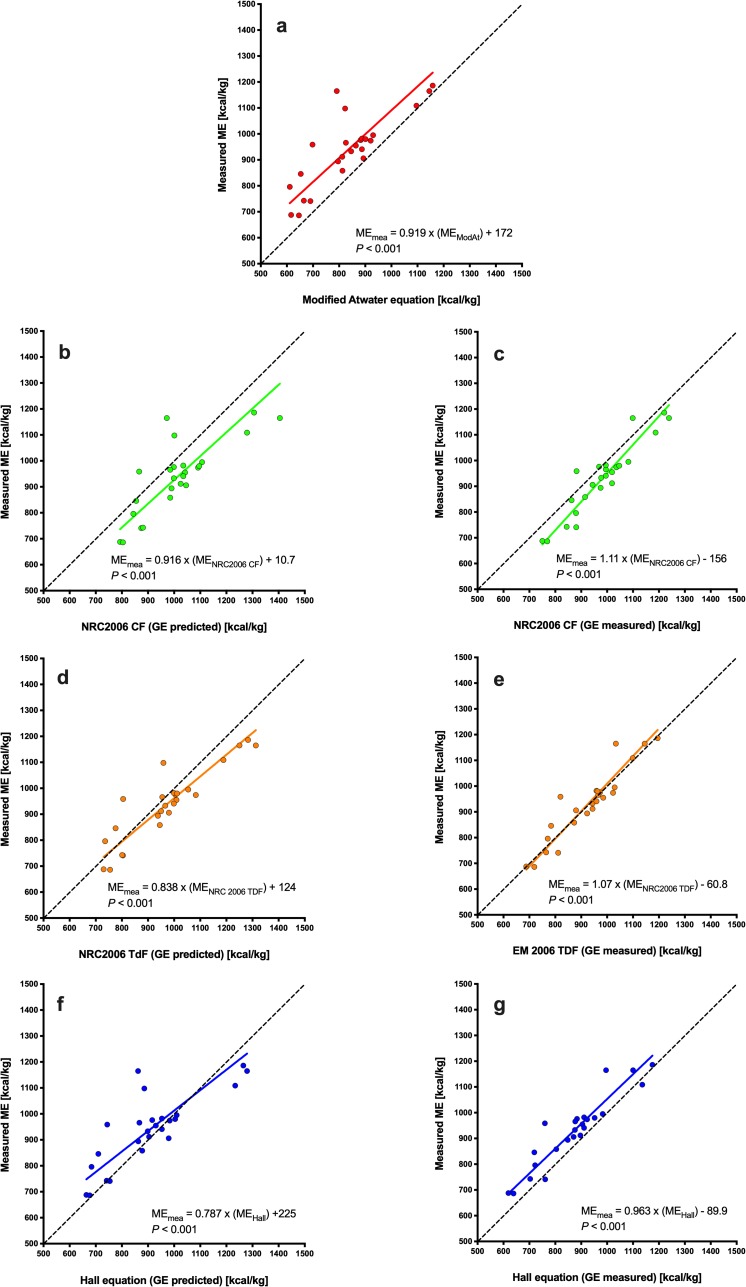
Deming regression plot depicting the relationship between measured and predicted metabolisable energy (ME) content in wet feline diets.The points represent results for individual foods, the solid line depicts the trendline from Deming regression, and the dotted black line represents the line of equivalence (where each unit increase in predicted ME equates to the same increase in measured ME. Different figures represent predictions made with modified Atwater (red, a), NRC 2006cf (green; b: predicted GE; c: measured GE), NRC 2006tdf (orange; d: predicted GE; e: measured GE), and the Hall equation for cats (blue; f: predicted GE; g: measured GE).